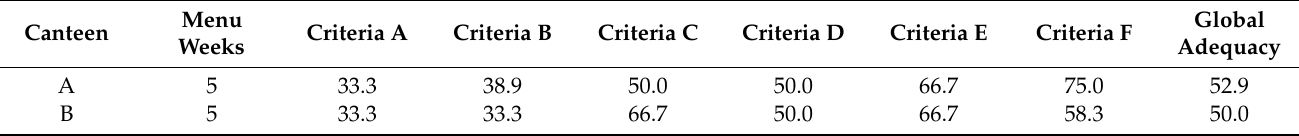
Table 1. Qualitative analysis of the lunch menu served in canteens (A and B) from public university (% of adequacy). Canteen